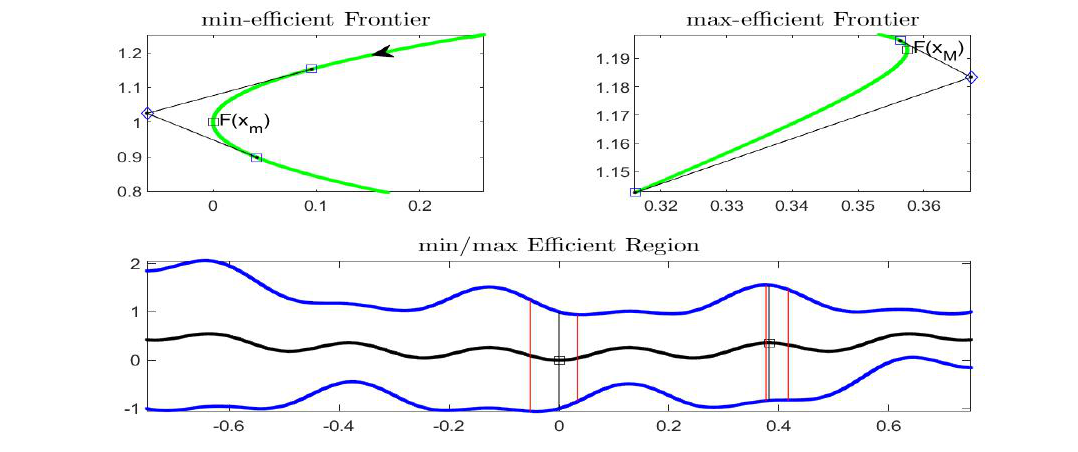
Figure 12. Complete Example: (top) efficient regions corresponding to x m and x M (top picture), obtained by tangency conditions. (Bottom) the efficient regions around the min and max points are delimited by vertical red lines.